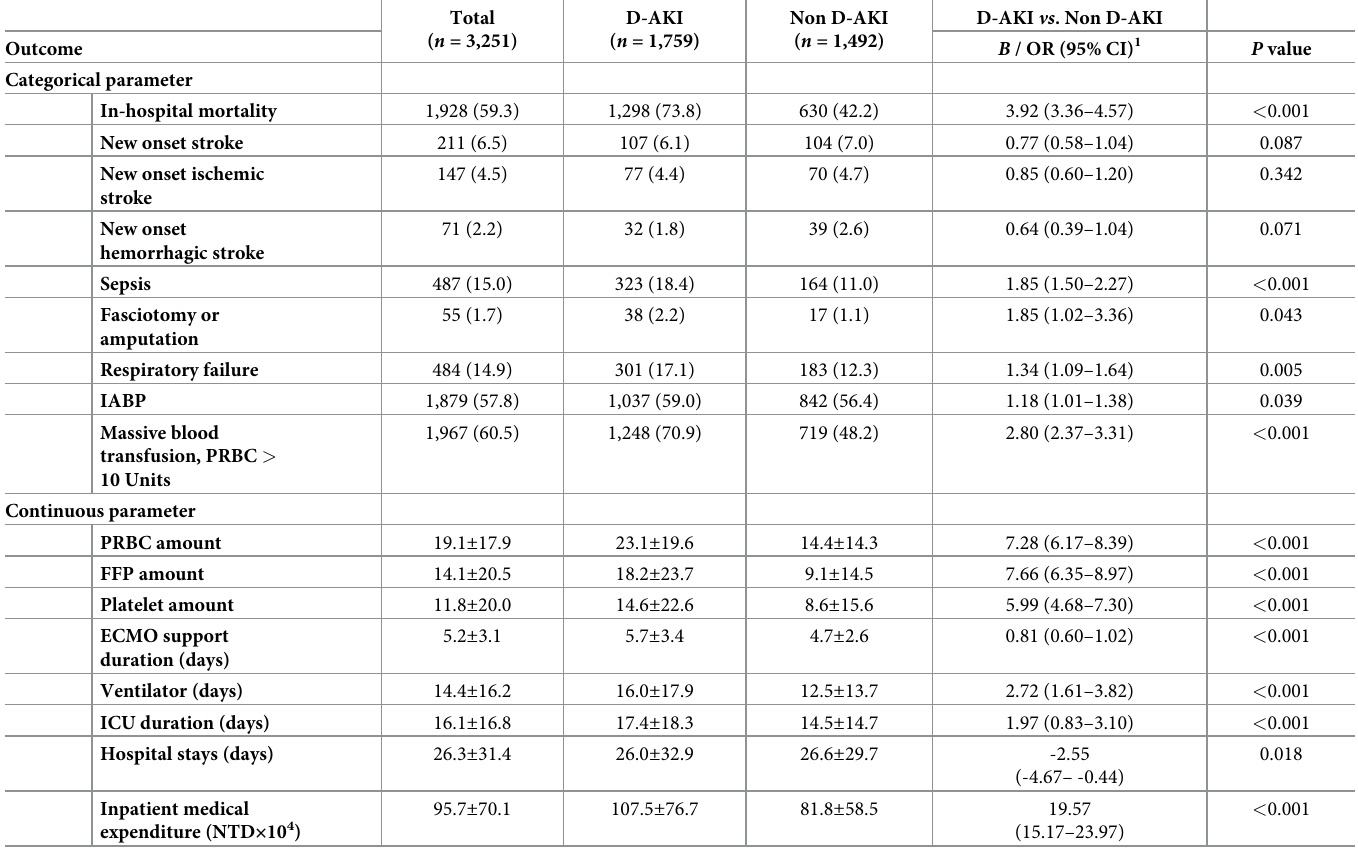
Table 2. In-hospital outcomes.